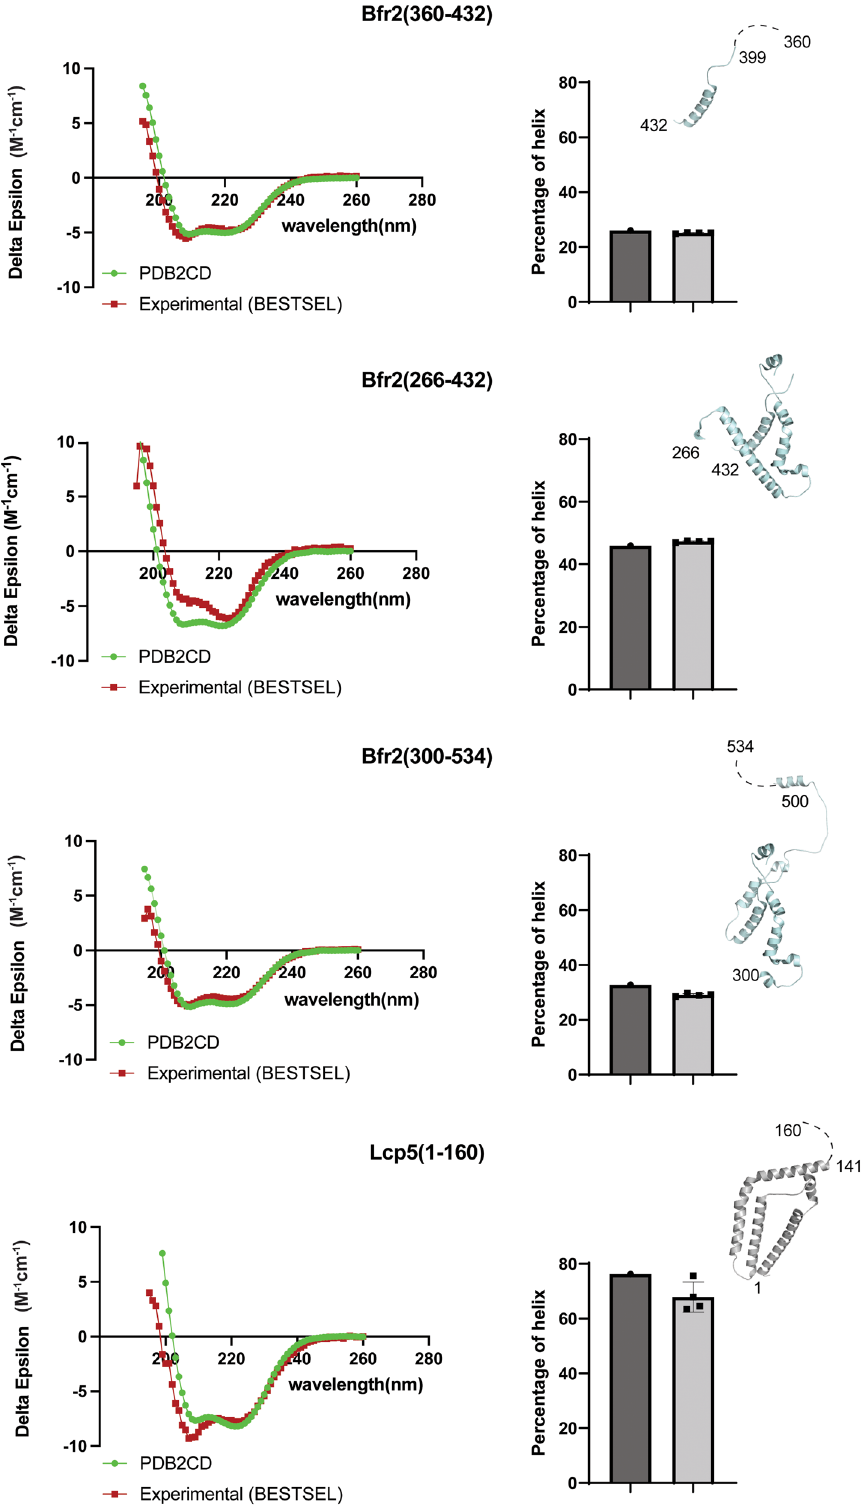
Fig. 2 Circular Dichroism (CD) spectra of Bfr2 and Lcp5 fragments and data fi tting. Left, the background-corrected Delta Epsilon ( Δε ) plots of fragments (red) collected at pH 7.4 in room temperature in comparison with those generated from the structures of fragments by PDB2CD (green). Right, comparison of the α -helix content for each protein fragment analyzed by BeStSel to that predicted from the structure of the corresponding protein fragment by PDB2CD. Error bars represent the experimental errors from three independent measurement of each protein